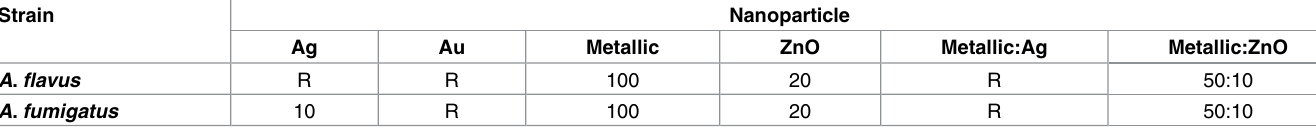
Table 2. Antifungal activity of NPs against A . flavus and A . fumigatus expressedas MICs ( μ g/mL).